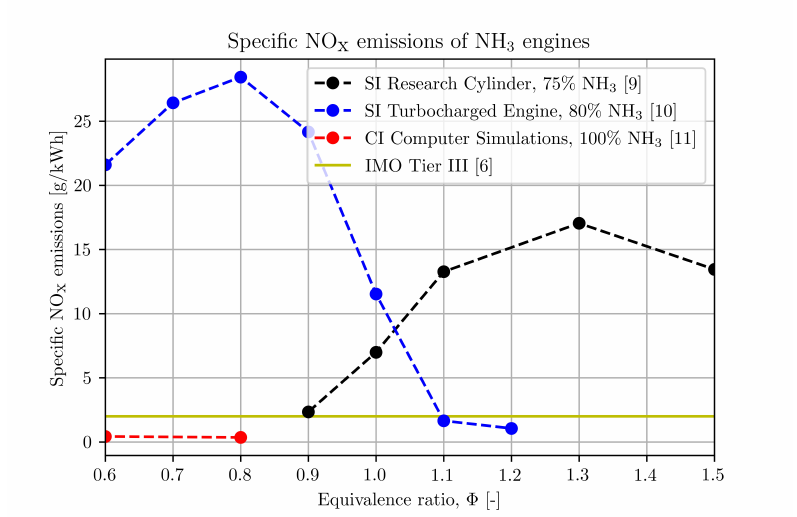
Figure 4. The specific NOx emissions of various NH 3 -H 2 engines as a function of equivalence ratio